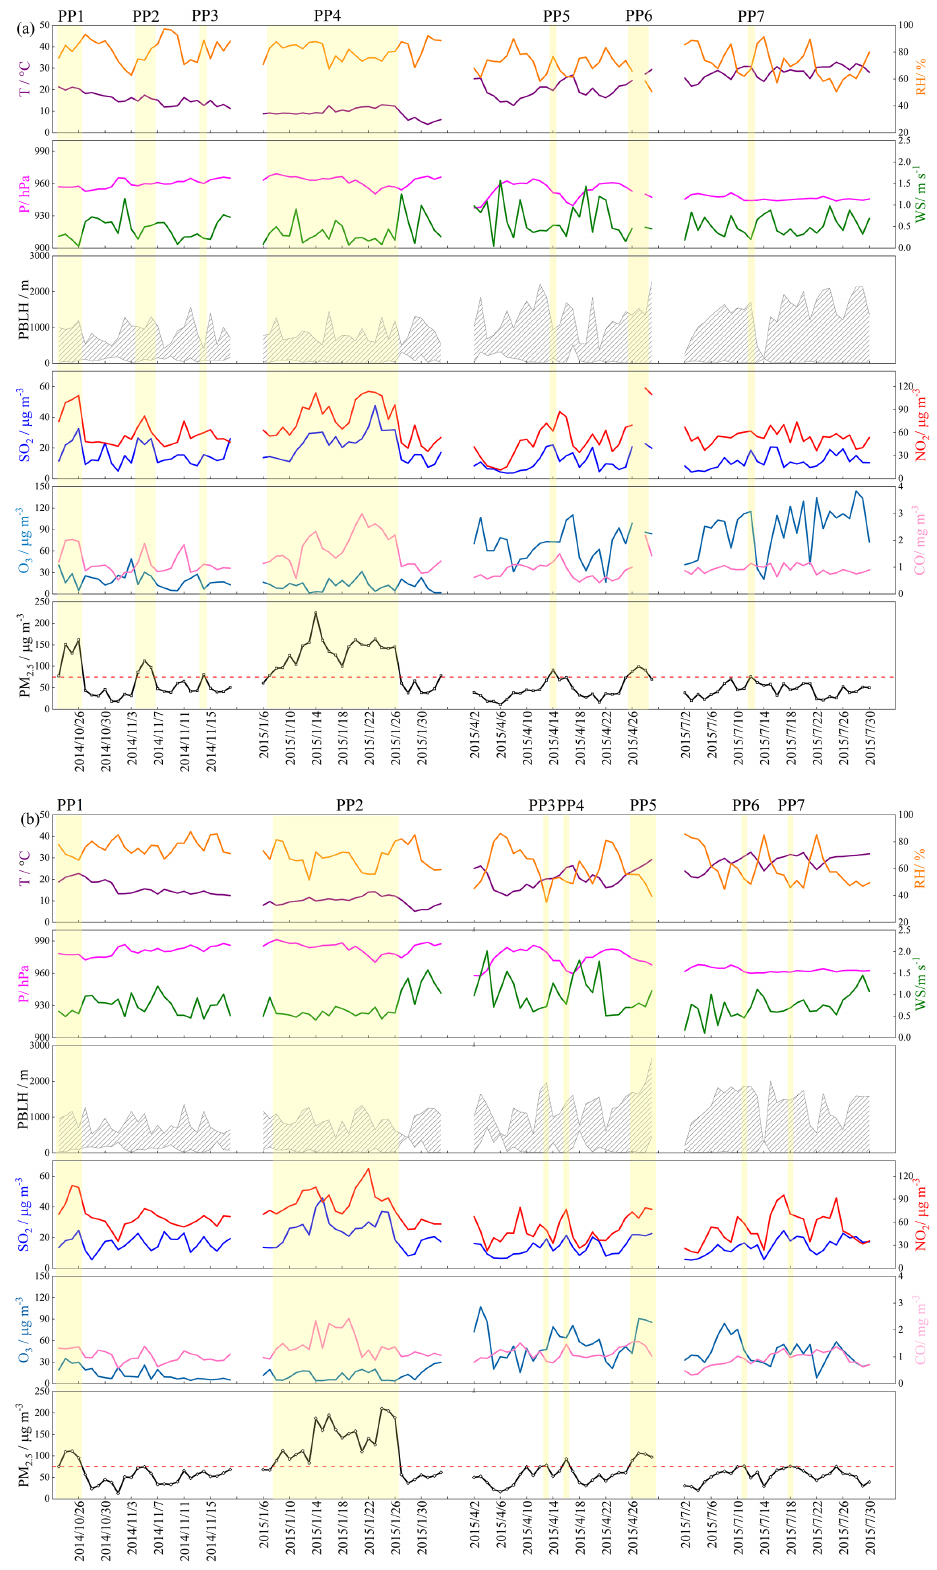
Figure 5. Temporal variations of meteorological parameters, gaseous pollutants, and PM 2 . 5 during the campaign at CD (a) and CQ (b) . Pollution episodes are highlighted by shaded